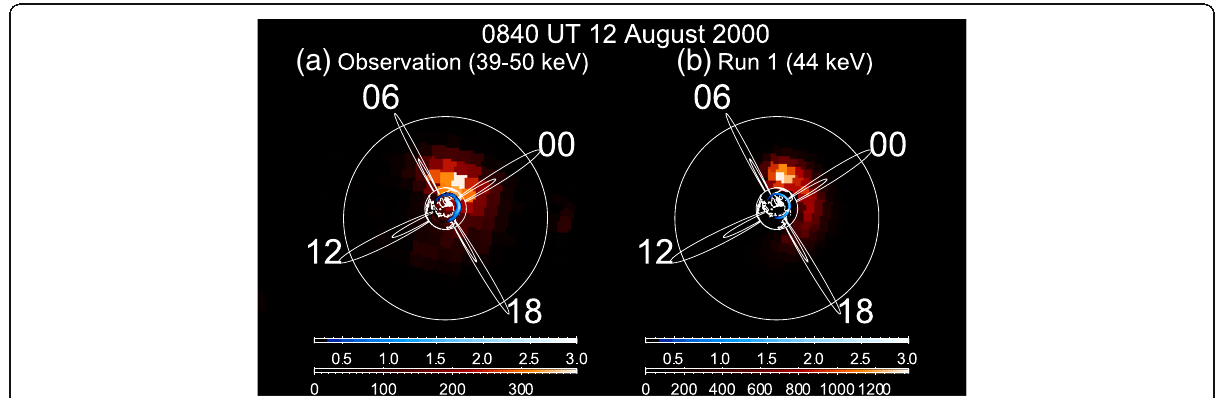
Fig. 12 Influence of ring current-ionosphere coupling on the ring current protons in terms of shielding. The flux of energetic neutral atoms is indicated by red color in the unit of 1/cm 2 s str keV. Precipitating proton flux into the ionosphere is indicated by blue color in the unit of 10 12 eV/cm 2 s. The left panel shows the observation made by the IMAGE satellite. The right one shows the simulation result. (Ebihara et al. 2011). a Observation (39 – 50 keV). b Simulation (44